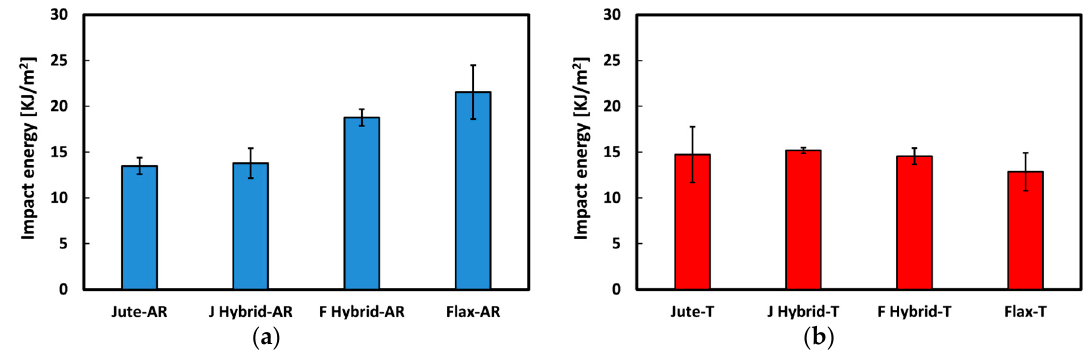
Figure 9. Impact energy at varying stacking sequence of ( a ) untreated and ( b ) treated